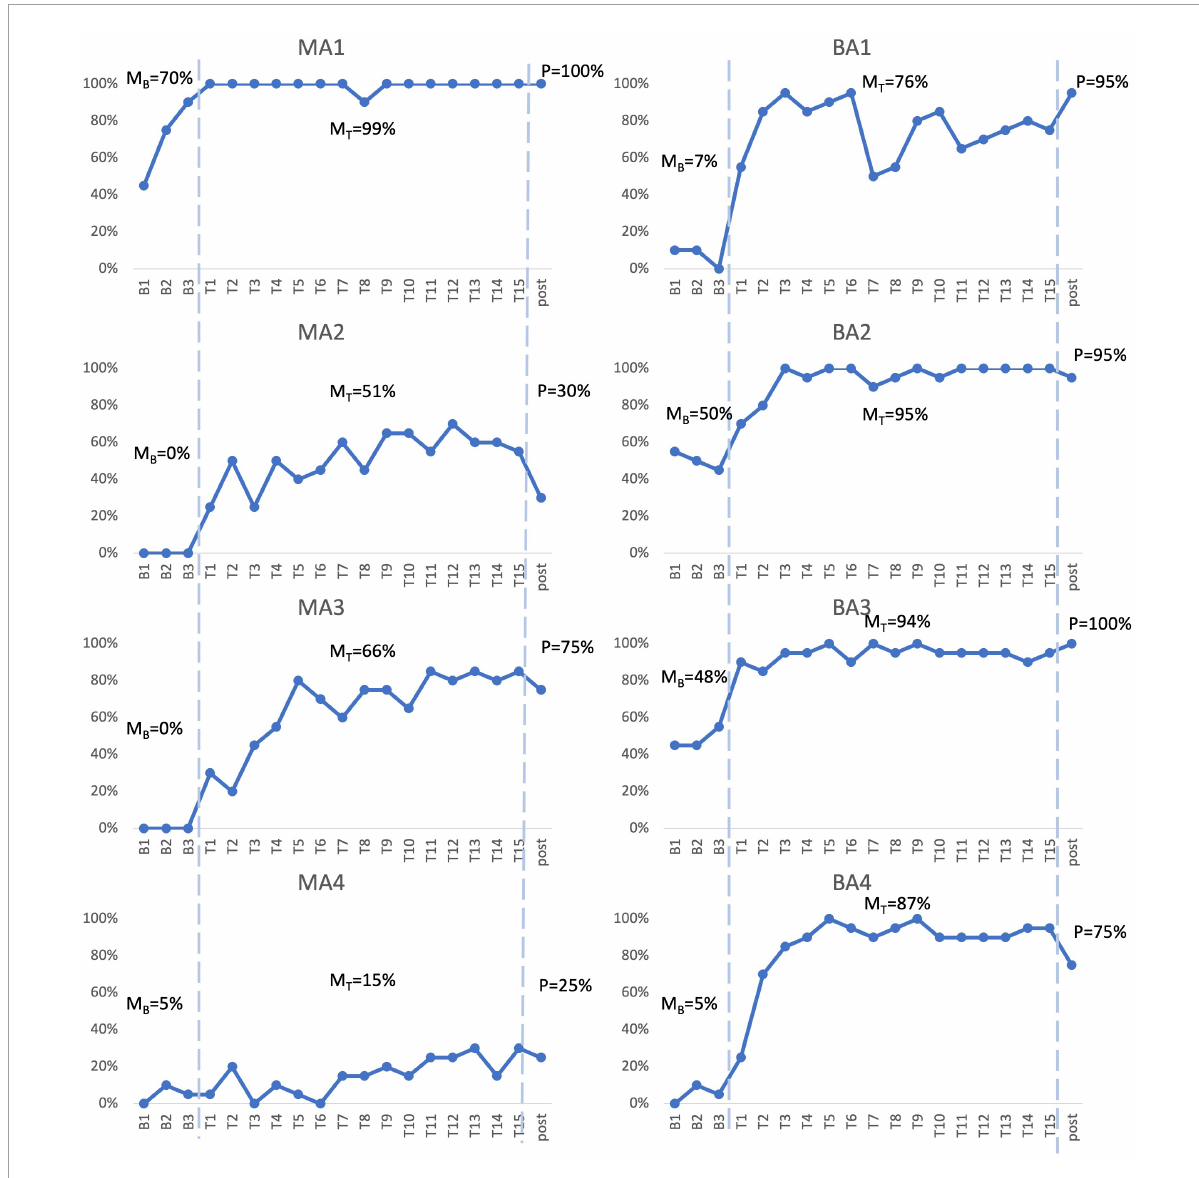
FIGURE2 Picture-naming probe results. Repeated probe data for all participants. Graphs reflect percent accurate production for treated items at baseline assessments, each therapy session, and post-treatment assessment. M B refers to mean accuracy of baseline assessments, M T refers to mean accuracy of therapy sessions, P refers to accuracy at post-therapy